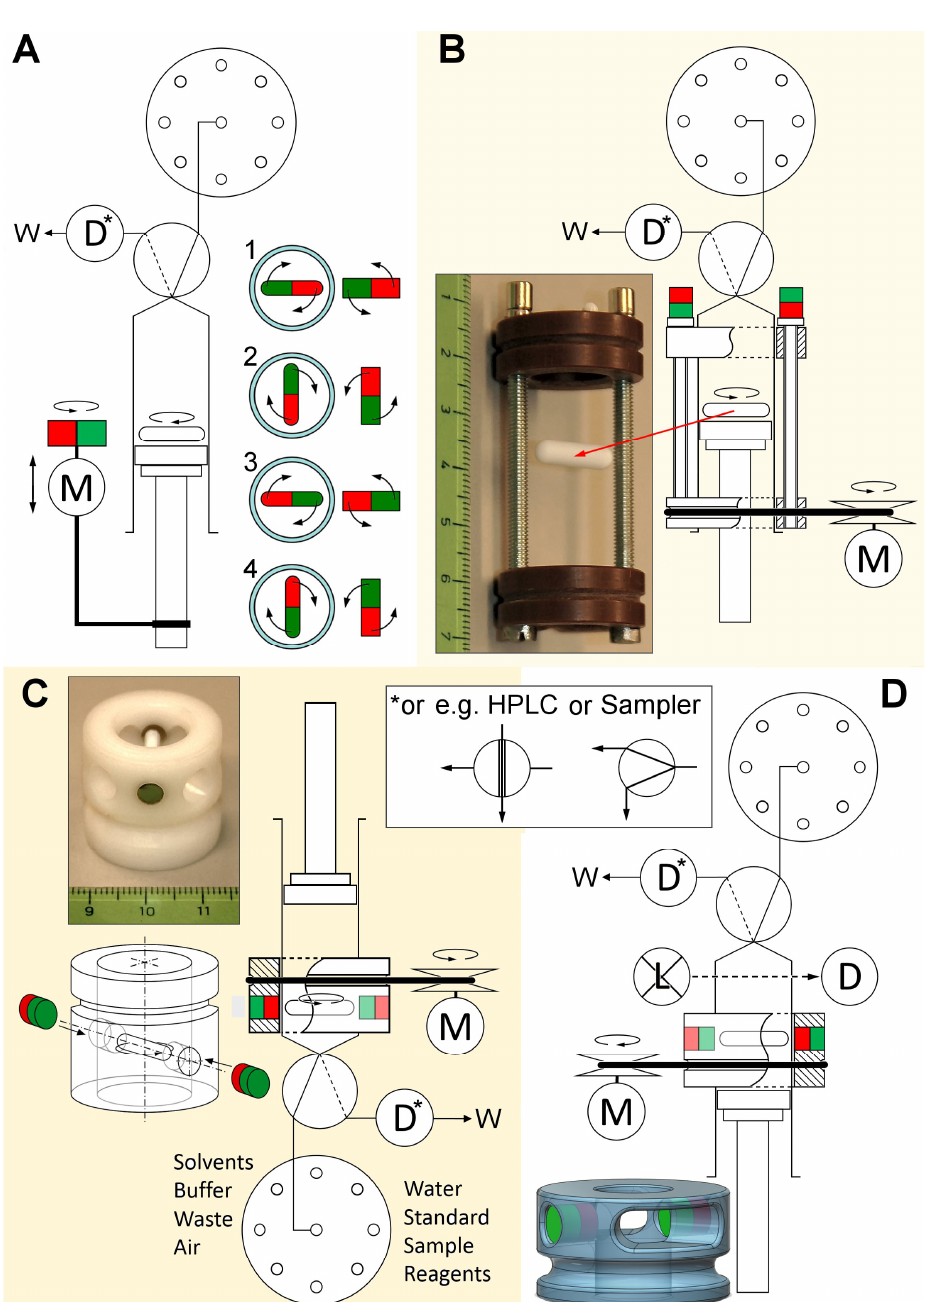
Figure 1. Modalities for system setup, syringe orientation, and stirring arrangements. Stir-drivers are shown in photographs with a levitated magnetic stirring bar. ( A , B , D ): Syringe in upright orientation, ( C ) Syringe used upside down. ( A ) Stirring induced by a closely placed motor with an attached bar magnet, ( B ) Stir-driver for the full stroke length of the syringe, ( C , D ) Stir-driver for fixed position. Upon turning the stir-drivers via a rubber ring and motor, they generate a rotating magnetic field around the syringe barrel. Abbreviations D—Detector, L—Light source, M—Motor,